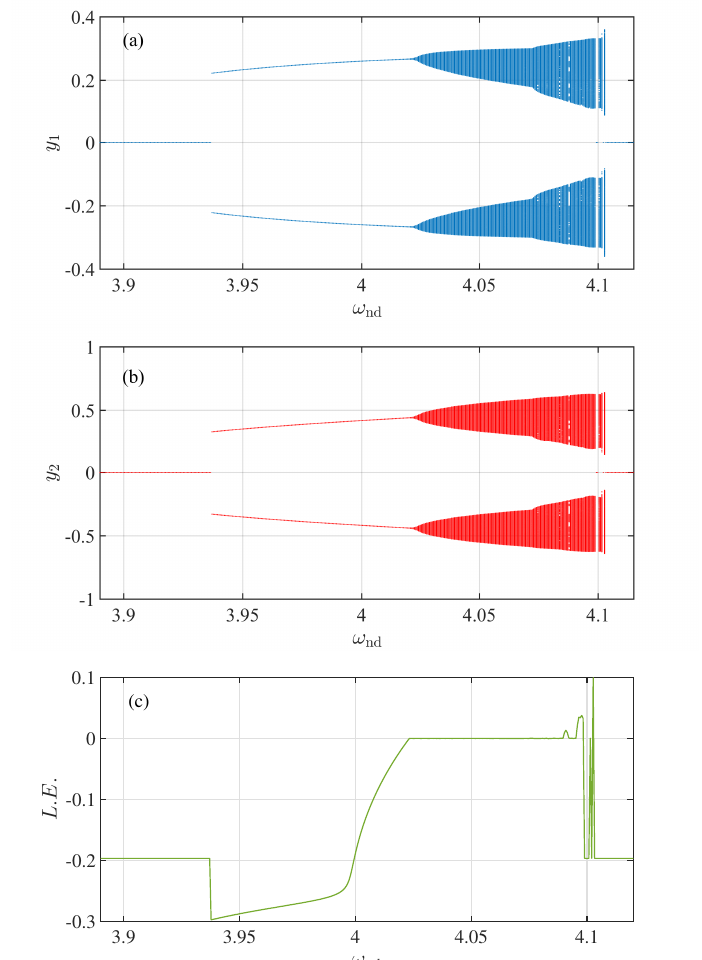
Figure 9. The bifurcation diagrams of the state variables y 1 and y 2 , and the corresponding maximal lyapunov exponent of the system. ( a ) Bifurcation Diagram of y 1 : The x -axis is the non-dimensional parameter ω nd and the y -axis is the sampled value of y 1 , ( b ) Bifurcation Diagram of y 2 : The x -axis is the non-dimensional parameter ω nd and the y -axis is the sampled value of y 2 , ( c ) The maximum lyapunov exponent: The x -axis is the non-dimensional parameter ω nd and the y -axis is the lyapunov exponent. The parameters are: ζ 1 = 0.0868, ζ 2 = 0.1036, t 1 = 0.2413, t 2 = 0.288, b 1 = 45.7143, b 2 = 54.5737, a 1 = 5.8548 × 10 − 3 , D 1 = 1.5, β = 11.11, µ = 1.1938, δ 1 = 1. The initial condition is considered as ( 0.333,0,0,0 ) . (Color